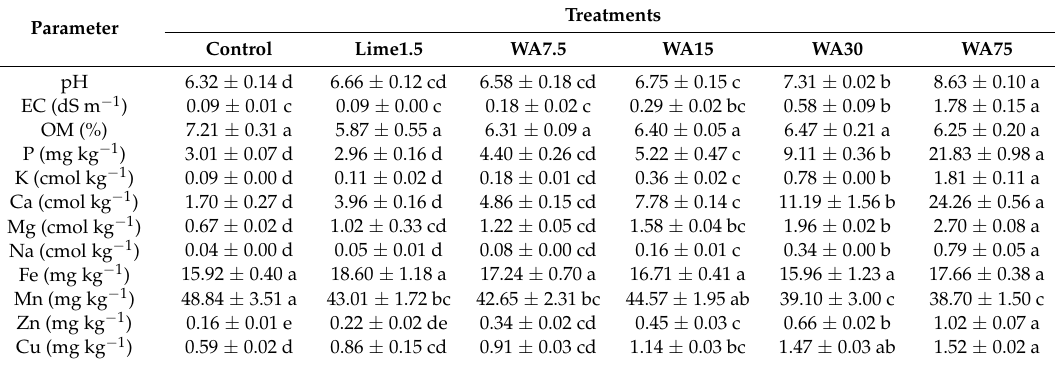
Table 3. Changes in the chemical properties of soil as a result of wood ash application.